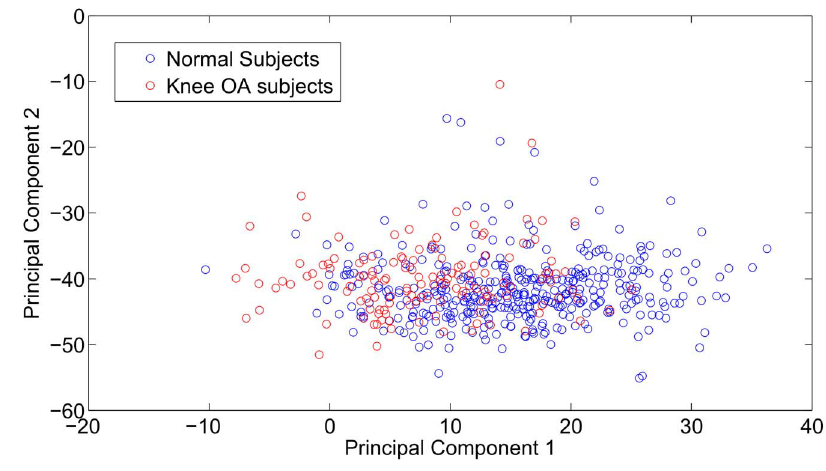
Figure 7. Projection of the GRF patterns in 2-D PC space (i.e. the first two PCs). The two classes are not separable.